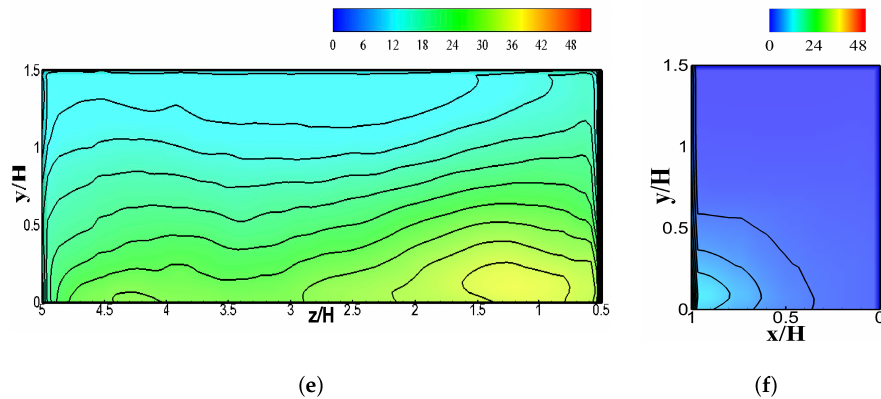
+ (cid:105) data on Building A (upwind